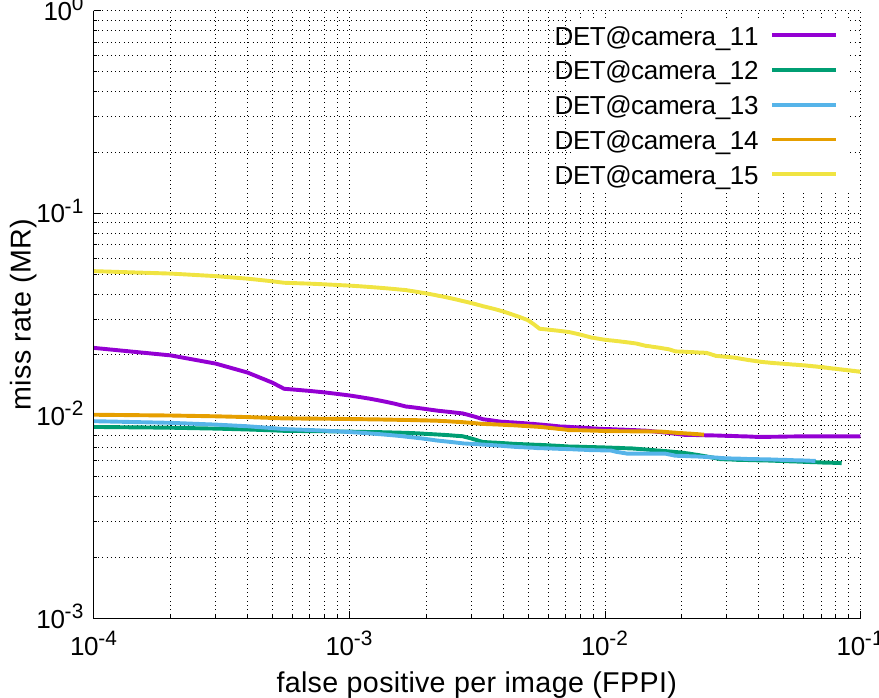
Figure 28. DET curves @ Cameras_11–15, informed-filters, some